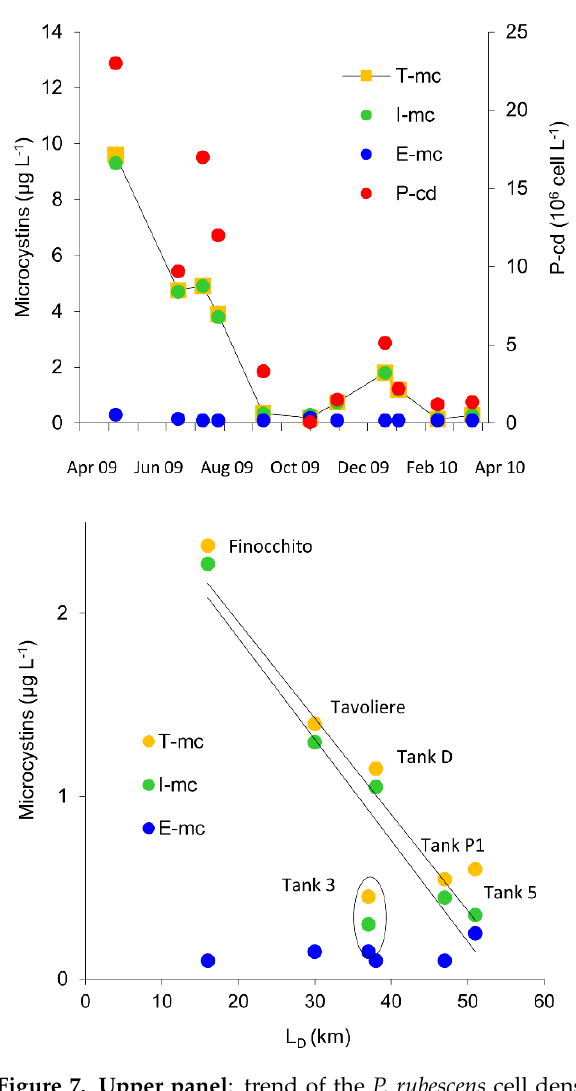
Figure 7. Upper panel : trend of the P. rubescens cell density (right scale) and of the microcystin concentrations (left scale) in the Finocchito splitter between April 2009 and April 2010. Lower panel : trend of the median microcystin concentrations distinguishing in total (T-mc) intracellular (I-mc) and extracellular (E-mc). Circle indicates the “anomalous” data related to Tank 3. A similar trend was followed by microcystin concentrations (T-mc = 0.3–9.6 µ g L − 1 ) with maximum values of total microcystin concentrations (9.6 µ g L − 1 ) of about 52% of the values detected at the P-chl-a peak in station St10 (18.3 µ g L − 1 ). After April 2009, total microcystin concentrations decreased but remained above 4 µ g L − 1 up to August; mini- mum concentrations were reached in October 2009 (0.2 µg L − 1 ). Subsequently, the micro- cystin concentrations increased again till the end of January 2010 when values of 1.8 µg L − 1 were detected. Then, total microcystin concentrations decreased to values of about 0.2–